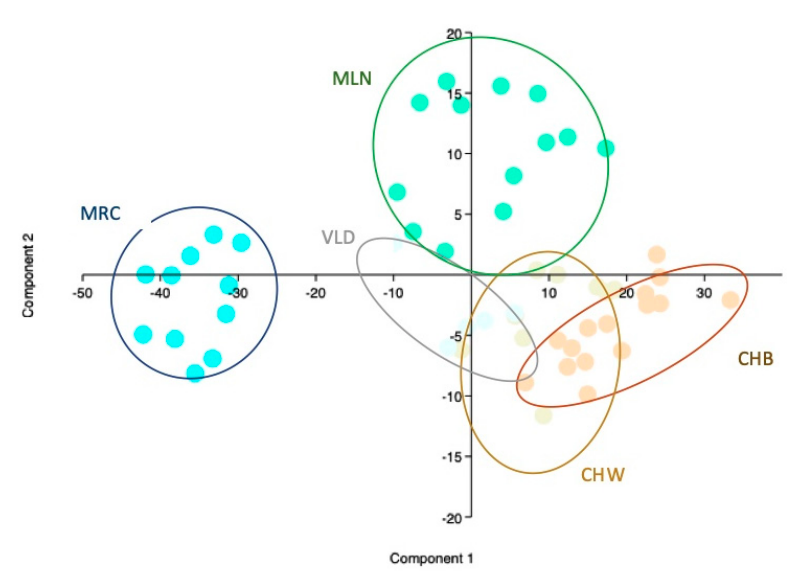
Figure 1. Scatter Plot principal component analysis (PCA) Physical Parameters *. * Every spot represents an egg, every color a breed (CHB = orange, CHW = beige, MLN = green MRC = turquoise, VLD = light blue) breed specific lines circling the eggs of each breed have been defined.